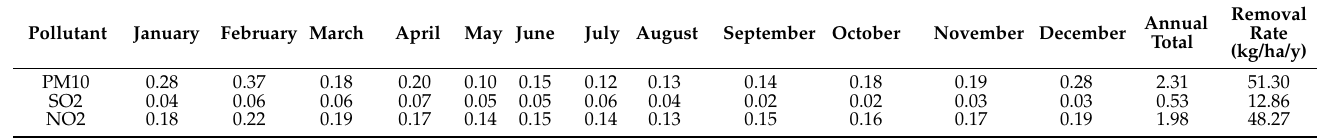
Table 6. Quantifying air pollutant removal in